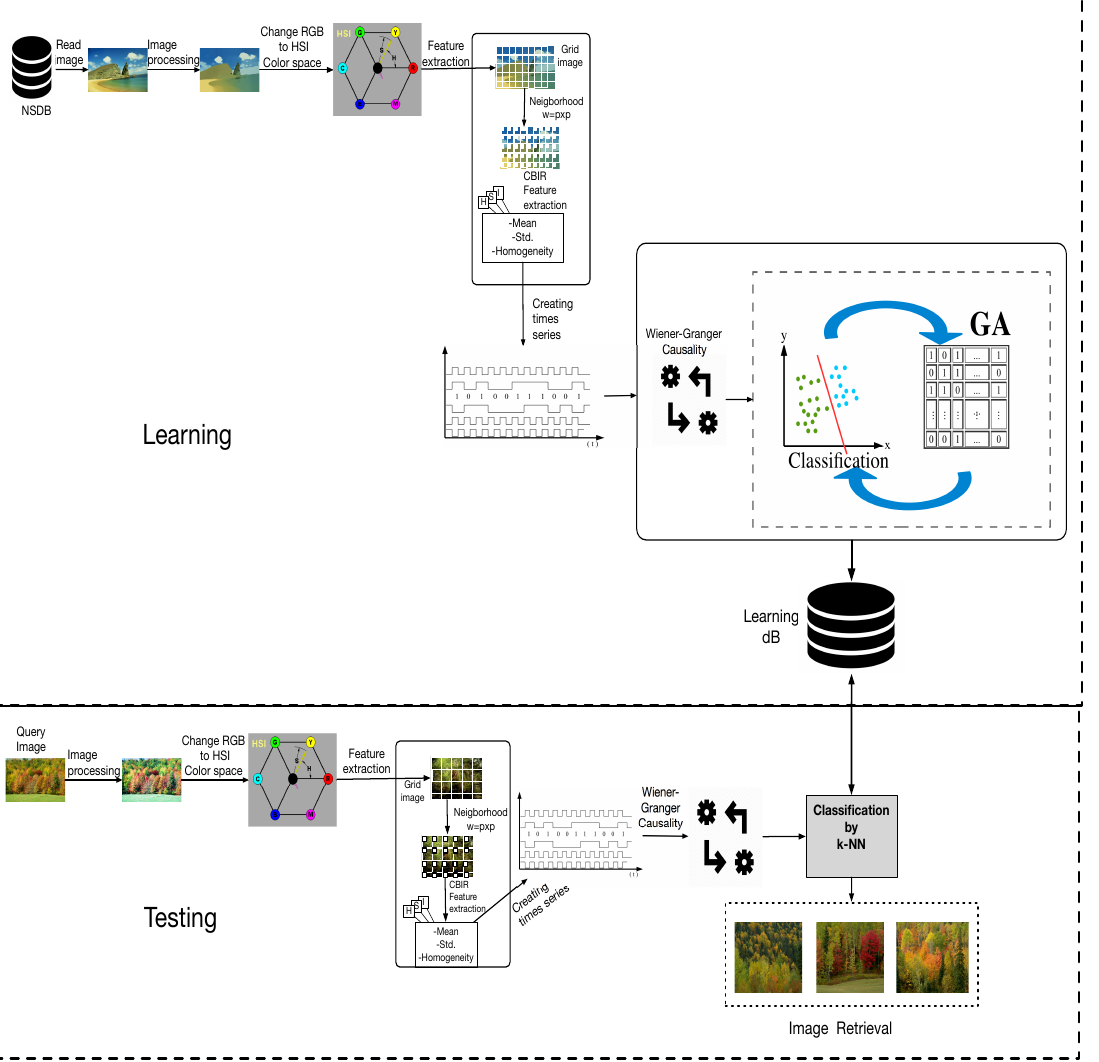
Figure 4. Learning and testing architecture for the classification